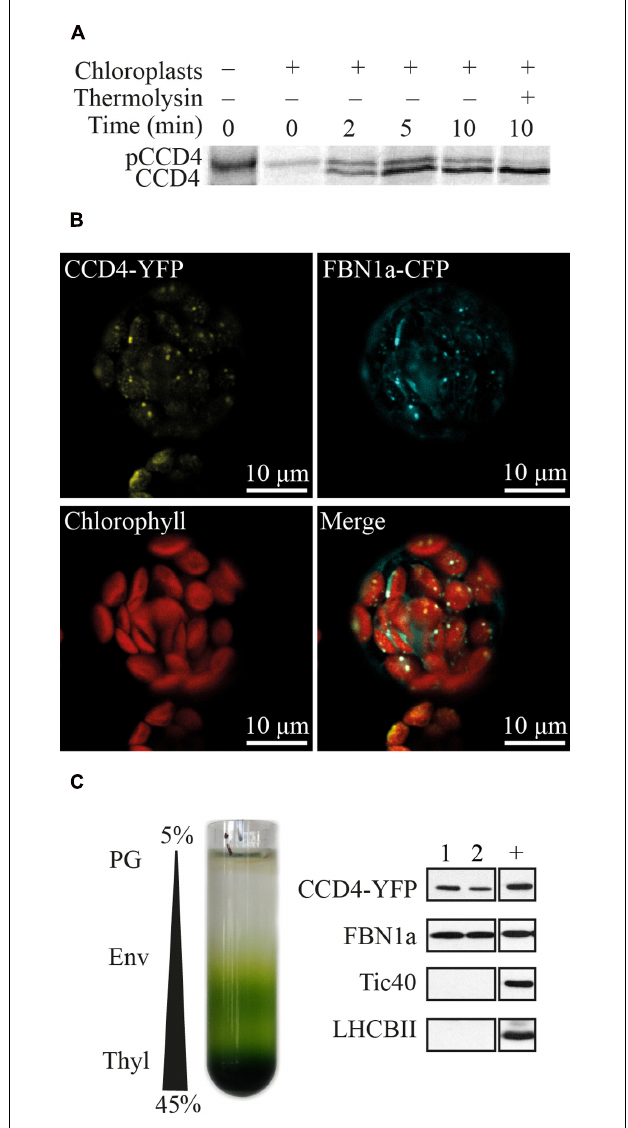
FIGURE 1 | Plastoglobule localization of CCD4. (A) Pre-[ 35 S] CCD4-6xHIS (pCCD4) was incubated with isolated Pea chloroplasts from 0 to 10 min in vitro . Upon import, mature [ 35 S] CCD4-6xHIS (CCD4) showed a lower molecular mass due to the removal of the transit peptide and unlike pCCD4 was resistant to thermolysin protease. (B) Colocalization of CCD4-YFP and FBN1a-CFP in isolated protoplasts of Arabidopsis thaliana . (C) Isolation of PG by chloroplast membrane fractionation on a discontinuous sucrose gradient (PG, plastoglobules; Env, envelopes; Thyl, thylakoids). Pure PG fractions (nos. 1 and 2) contain recombinant CCD4-YFP. Tic40, FBN1a and LHCBII are envelope, PG and thylakoid markers, respectively. + , positive control which corresponds to a membrane fraction containing all four